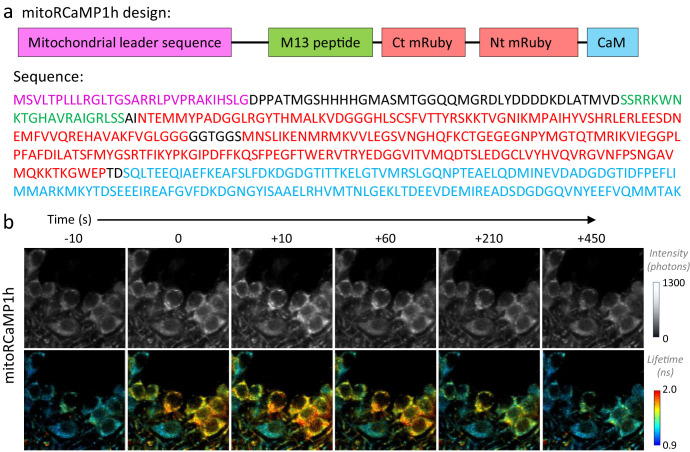
Design of the mitochondrially targeted RCaMP1h.(a) Top: Schematic representation of mitoRCaMP1h. Abbreviations indicate the mitochondrial leader sequence from the Cox8 subunit (as used in Li et al., 2014), added to the RCaMP1h sensor that includes the calmodulin (CaM) and M13 peptide, and the circularly permuted mRuby (Akerboom et al., 2013). The abbreviations Nt and Ct correspond to the amino and carboxy-termini of mRuby, respectively. The size of the boxes does not reflect the length of the sequences. Bottom: Amino acid sequence of the mitoRCaMP1h sensor, with colors matching the schematic representation in the top panel. (b) Filmstrip of DGCs in an acute hippocampal slice from a juvenile mouse, expressing the RCaMP1h sensor in the mitochondria (mitoRCaMP) and imaged using 2p-FLIM. Upon stimulation at time zero, the mitoRCaMP fluorescence intensity (top) and lifetime (bottom) promptly increased and then decayed over the span of several minutes.